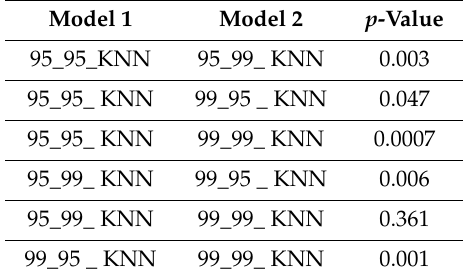
Table 15. p -value for t -test comparison for KNN models (tested against cleaned data).